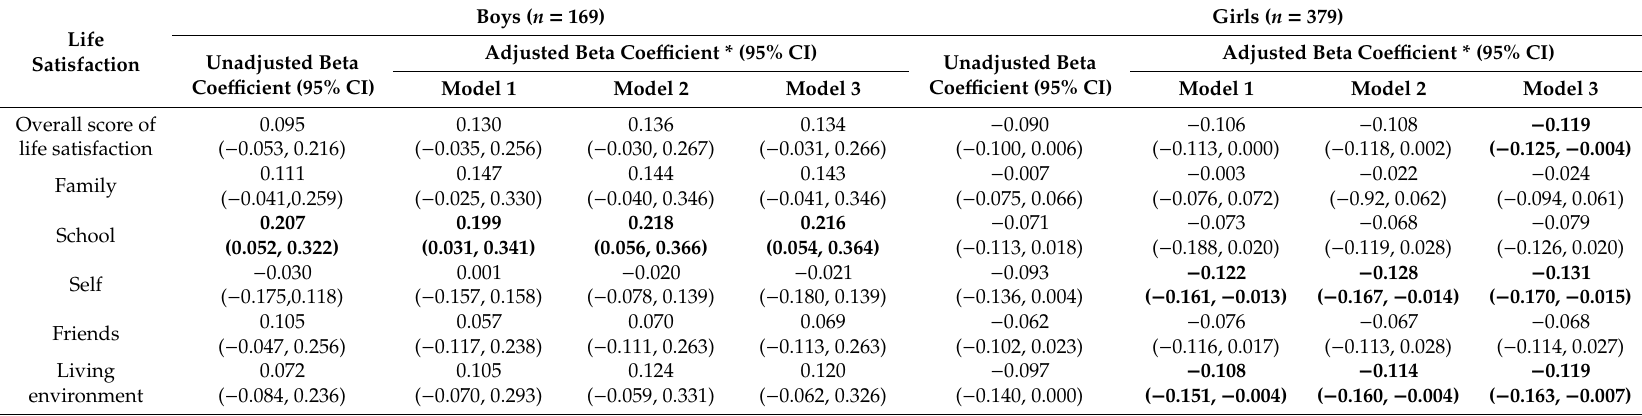
Table 3. Relationships ( β , 95% CI) between life satisfaction score and a “high sugar, high fibre, high DED and low fat” dietary pattern among adolescents aged 13 years in